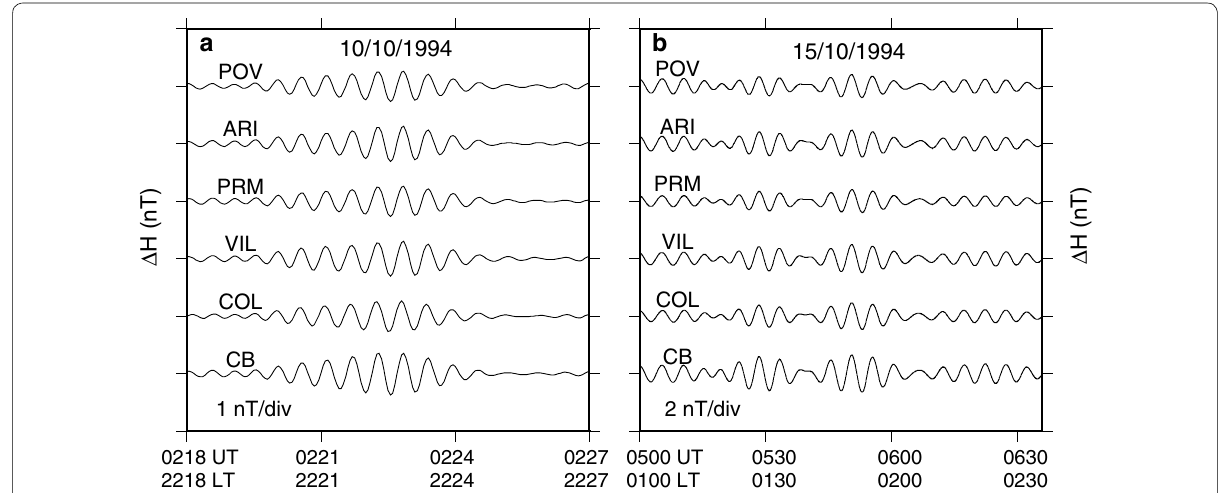
Fig. 3 Nighttime ULF waves in Pc3 and Pc5 bands after narrow band filtering. a Pc3 pulsation with center frequency in 30.3 mHz and frequency bandwidth of 4 mHz. b Pc5 pulsation with center frequency in 3.33 mHz and frequency bandwidth of ±